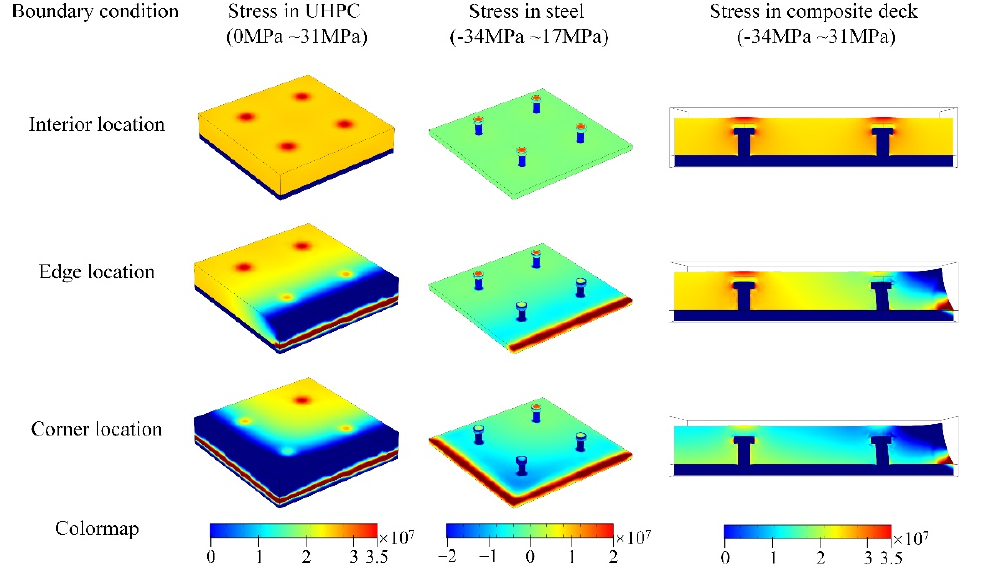
Figure 11. Stress distribution in the edge or corner of UHPC–steel composite deck.